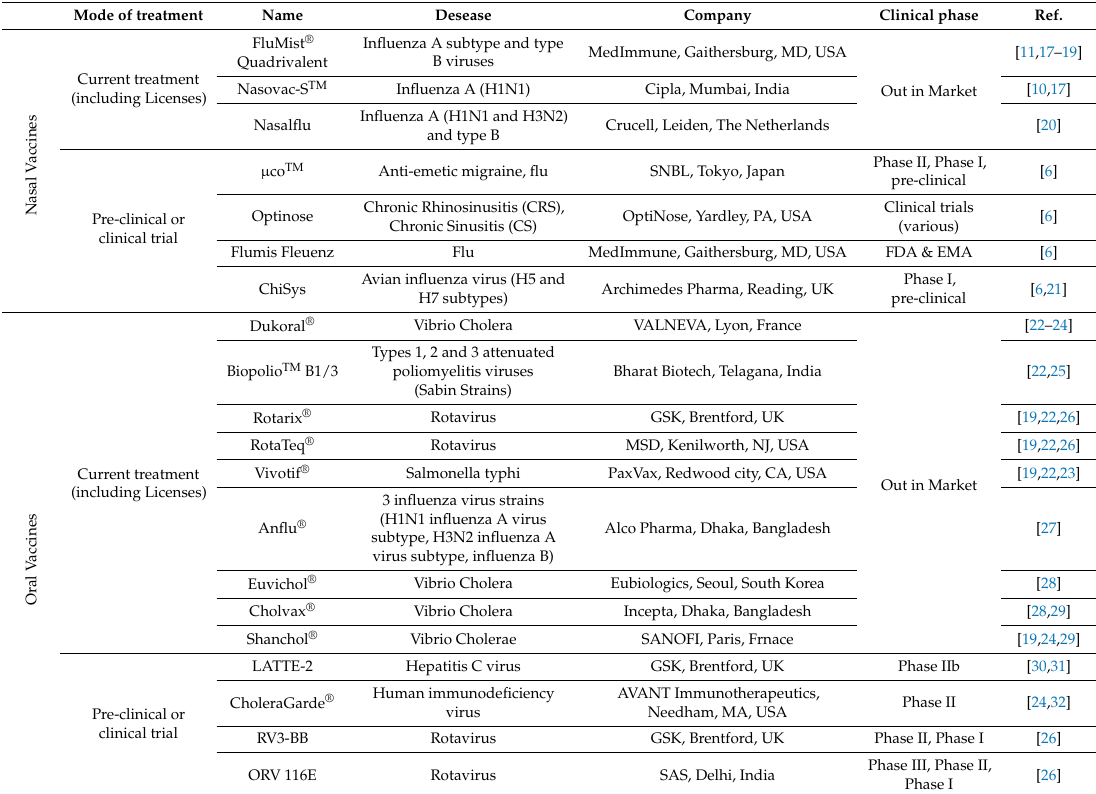
Table 1. Development of oral and nasal